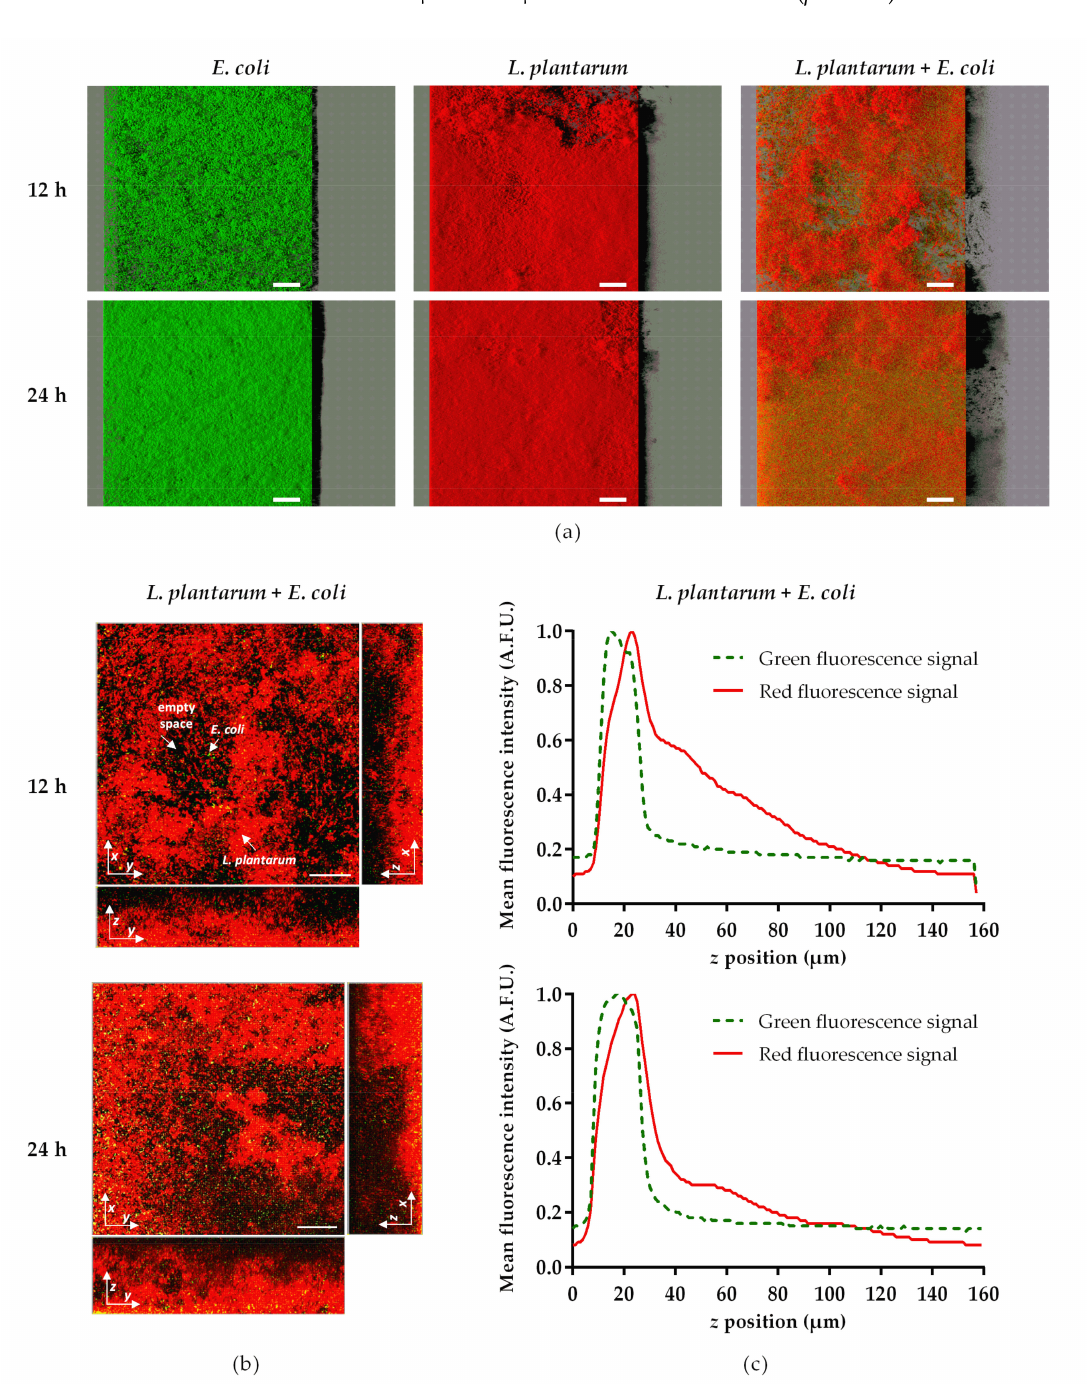
Figure 4. Spatial heterogeneity of 12- and 24-h biofilms from single- ( E. coli CECT 434 GFP and L. plantarum ) and dual-species ( L. plantarum + E. coli CECT 434 GFP) cultures formed on silicone coupons: ( a ) aerial, three-dimensional (3D) view of the biofilms (shadow projection on the right); ( b ) section views of the CLSM images presented in ( a ) for the L. plantarum + E. coli CECT 434 GFP biofilms; and ( c ) distribution of normalized red and green fluorescence intensity values (arbitrary fluorescence units (A.F.U.)) along the vertical ( z ) biofilm position. The images in ( a , b ) were obtained from confocal z -stacks using IMARIS software. The white arrows in ( b ) indicate the presence of E. coli CECT 434 expressing GFP (labeled in green), L. plantarum (counterstained in red with Syto61), and empty spaces within the biofilm. Some yellow regions appear due to the red and green being superimposed. The white scale bars correspond to 50 µ m in ( a ) and 100 µ m in ( b